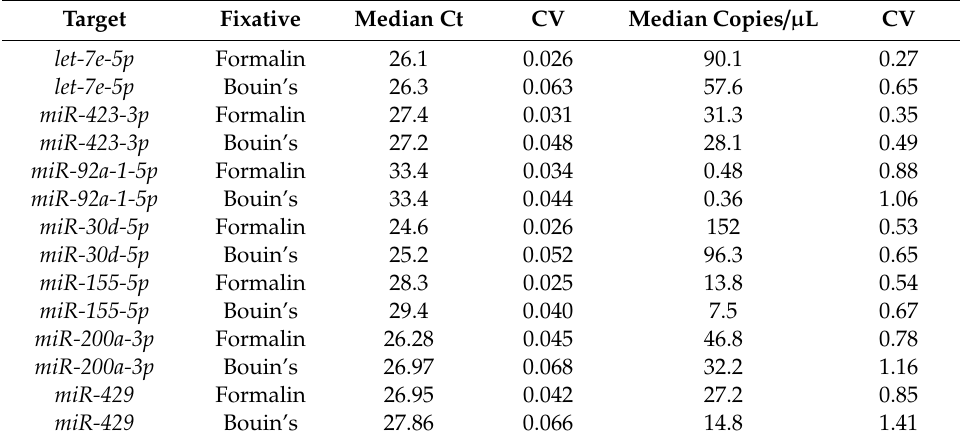
Table 3. By comparing Ct values in formalin- and Bouin’s-fixed specimens, a significant correlation